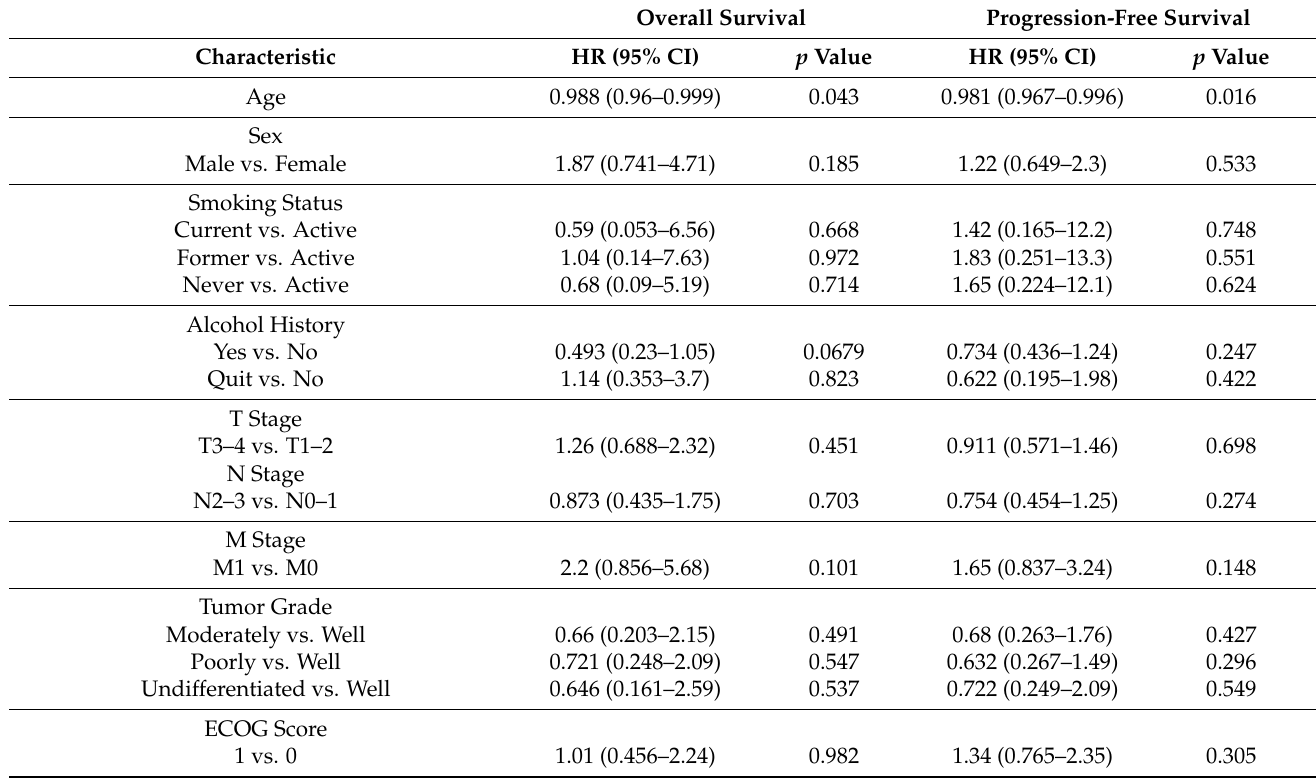
Table 2. Univariate cox proportional hazards regression analysis of OS and